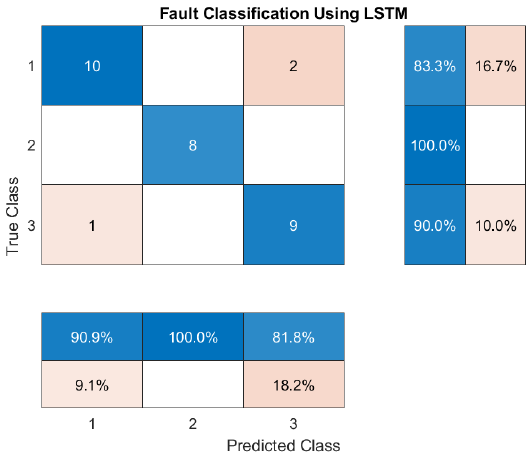
Figure 7. Confusion Matrix for LSTM Univariate Model. Table 7. LSTM Univariate Performance.